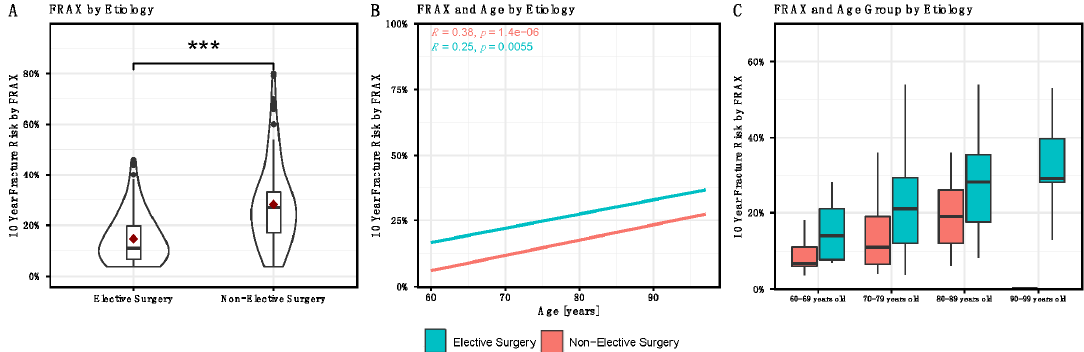
Figure 1. ( A ): FRAX ® Score by Aetiology: ( A ): Distribution of FRAX-Score by Aetiology. FRAX score was found to be significantly higher in the trauma related group (NES) than in the Elective Care group, indicating that the fracture patients had a significantly higher risk of subsequent fracture than the Elective Care patients. ( B ): FRAX ® Score and age by Aetiology. The FRAX score and thus the fracture risk increases continuously with age in both groups. ( C ): FRAX ® Score by Age Groups and Aetiology: A comparison of the age groups also shows a higher fracture risk in the trauma group. (***)- p -value < 0.001.